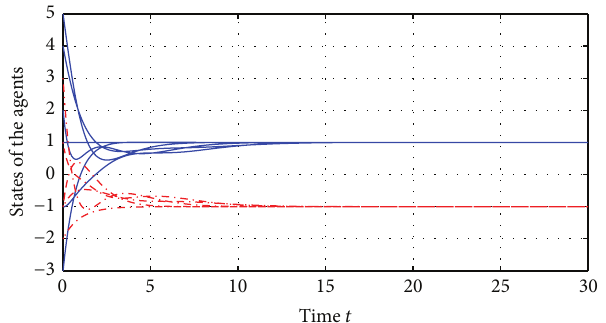
Figure 2: State evolution of agents on the structurally balanced coopetition network G 𝑠 .